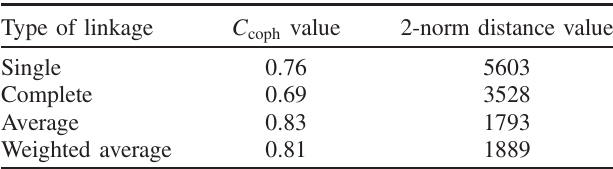
FIG. 8. Dendrogram of our data. Horizontal and vertical axes represent students and ultrametric distances, respectively. The inconsistency coefficients are reported and seven clusters ( α 1 , α 2 , β 1 , β 2 , γ , δ , ε ) are taken into